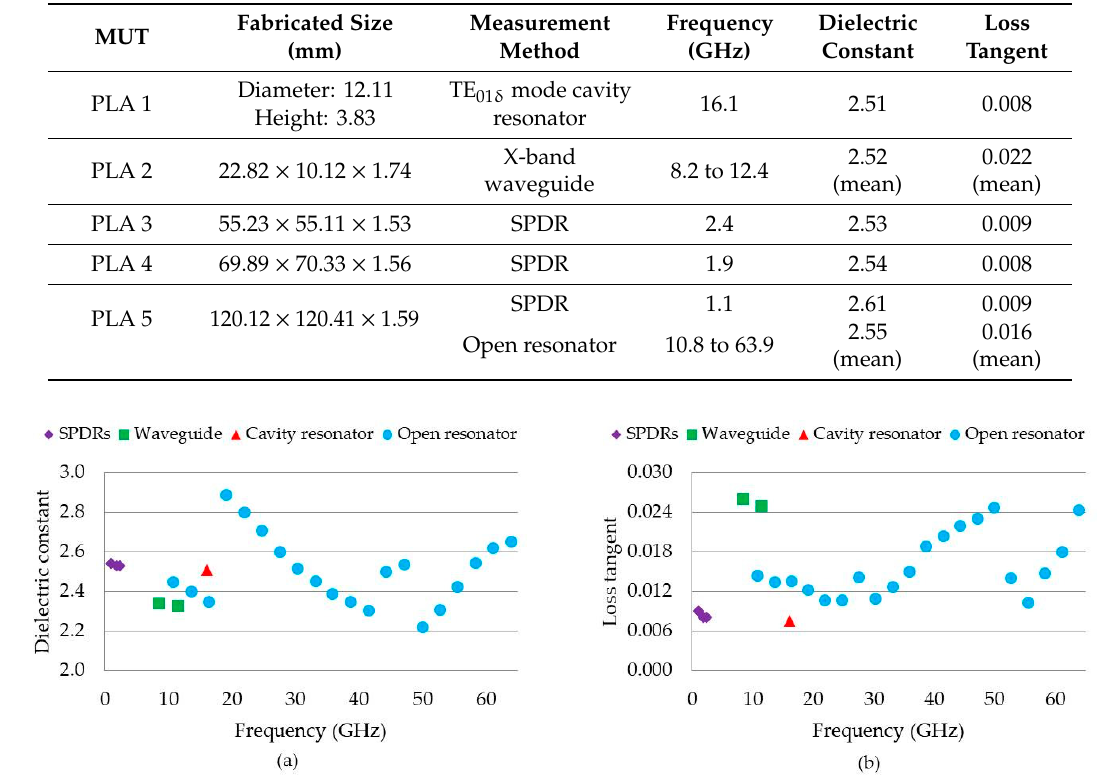
Table 6. Measured fabricated sizes, methods, and frequencies, together with the dielectric constant and loss tangent results of the PLA MUTs.